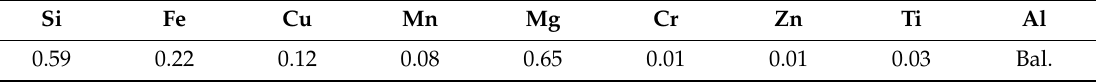
Table 1. Chemical composition of 6014-T4 aluminum alloy sheet (wt.%).